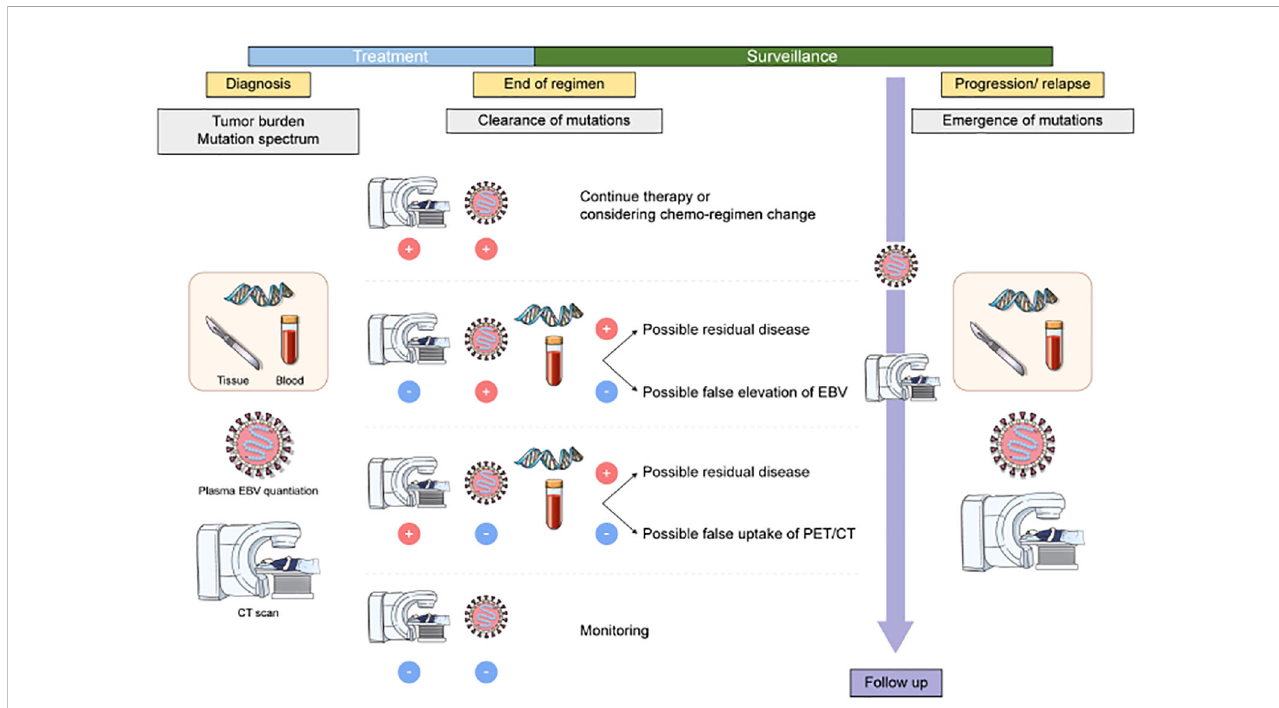
FIGURE 6 Application of liquid biopsy in patients with ENKTL. Upon diagnosis, baseline samples are collected. Once minimal residual disease (MRD) has been detected via liquid biopsy, further treatment options are considered. An additional series of samples can be collected during relapse to monitor changes in the patient, followed by initial